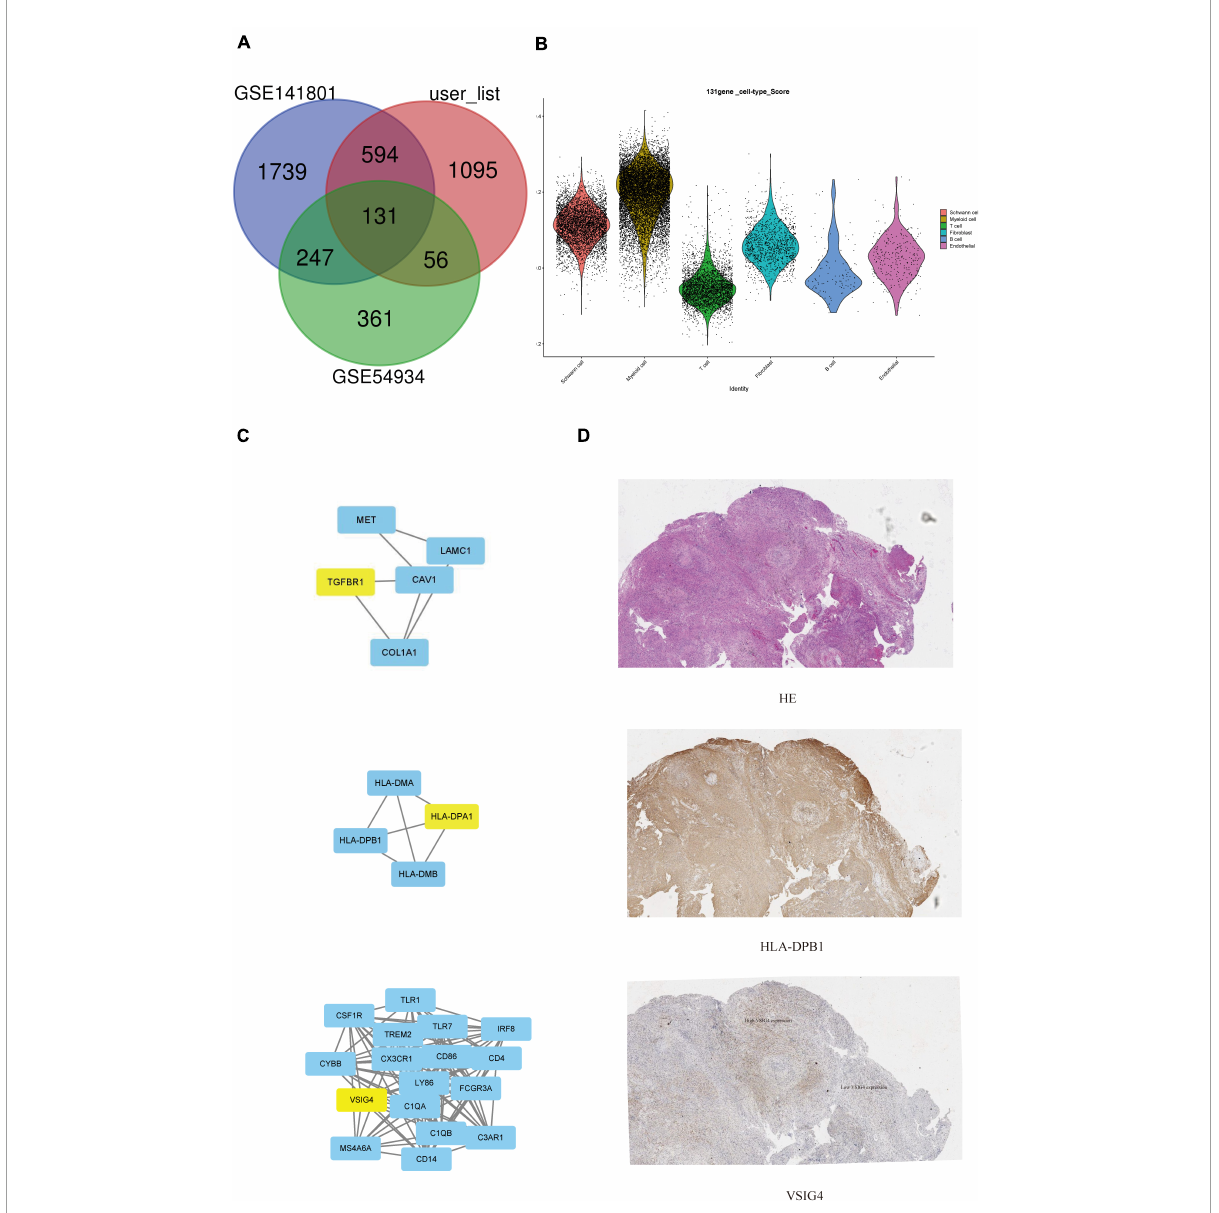
FIGURE5 Search for potential biomarkers of VS in conjunction with gene expression omnibus (GEO) database. (A) Venn diagram of common specific genes. (B) Violin plots showed the scaled expression levels of the 131 overlapping genes in the sub-cluster. (C) Protein interaction network centered on hub gene. (D) Immunofluorescent staining of VSIG4 and HLA-DPB1 in paraffin-embedded VS tissue sections. The detected proteins using respective antibodies in the assays are indicated on the VS